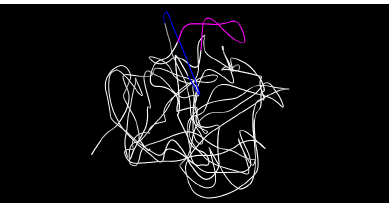
Figure 7. The tertiary structure visualization figure shows the partial fragments of a protein chain after the predicted structure ( blue ) and the actual structure ( red ) are